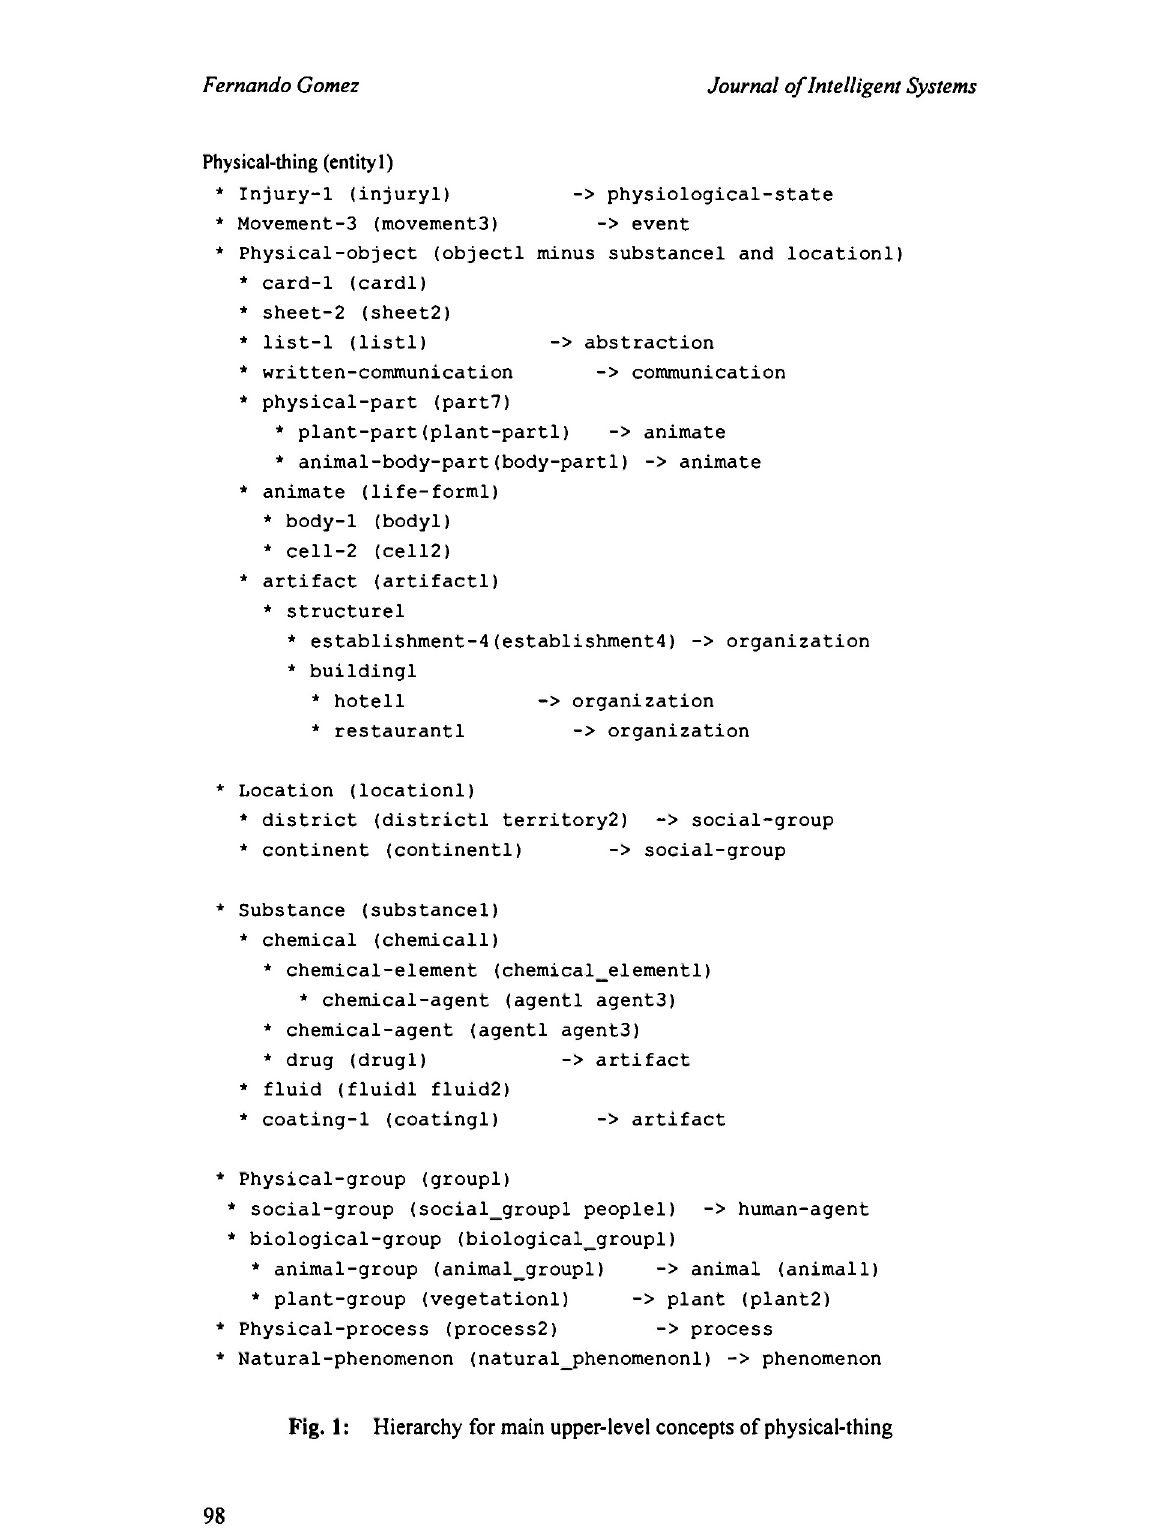
Fig. 1: Hierarchy for main upper-level concepts of